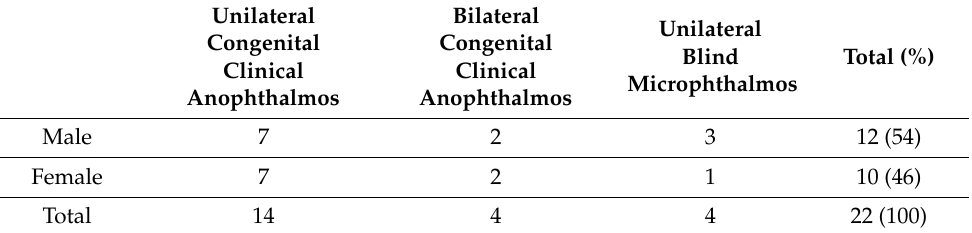
4 of 16 Figure 2. Recruitment of study participants. 3. Results 3.1. Study Population Of the patients, 45.5% were female and 54.5% were male. At the time of the study, they were on average 15.7 years old (from 8 to 23 years). Among them, 14 had a diagnosis